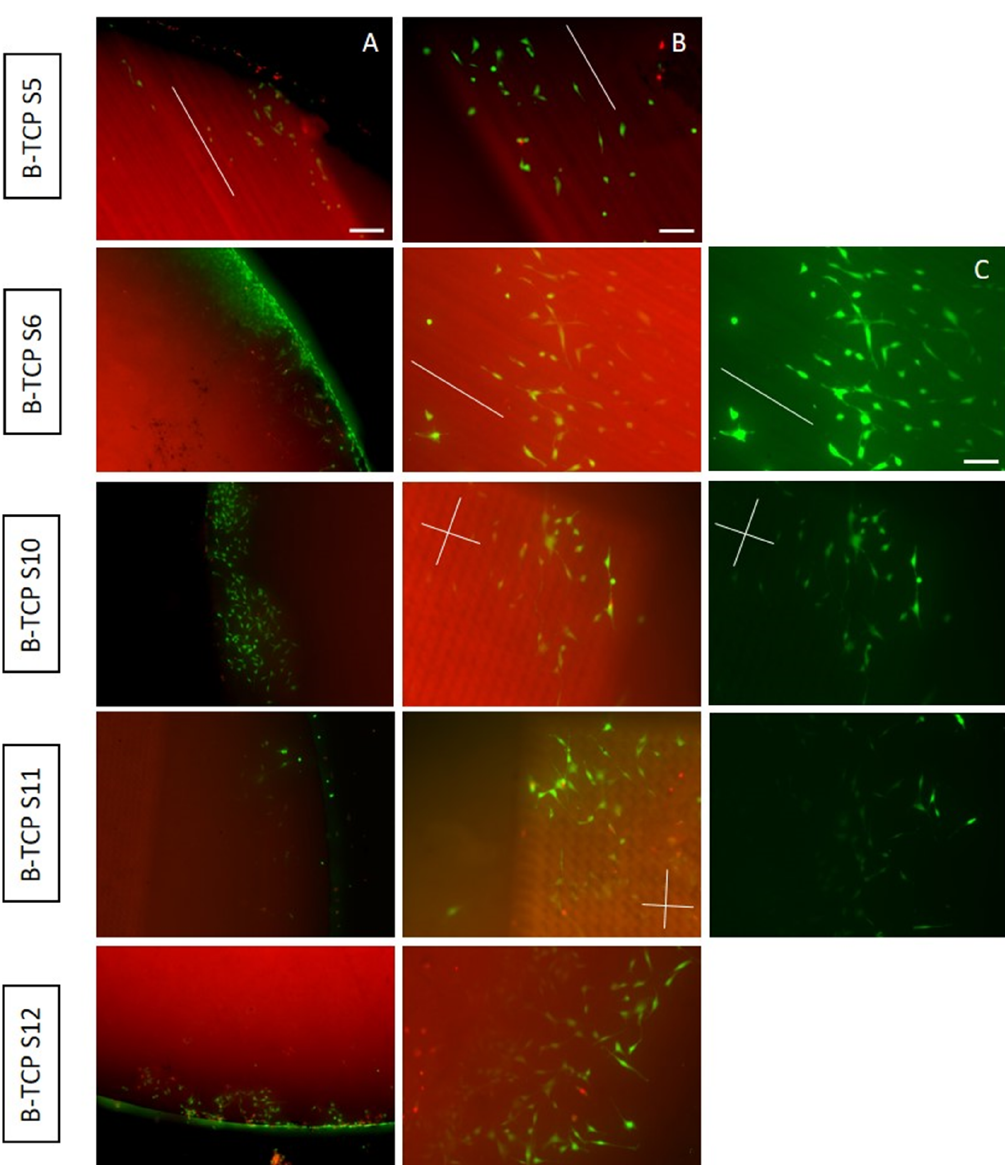
Figure 9. Fluorescence microscopy images of live/dead staining of MC3T3 mouse calvaria cells’ distribution 7 days in culture on different B-TCP ceramic laser-patterned surfaces. Living cells stain green, whereas dead cells stain red. The white lines show the lines of the pattern on the samples. ( A ) Overview images with scale bar of 200 µm. ( B ) Detailed images with scale bar of 100 µm. ( C ) Detailed images without a red filter clearly show that cells grow following the pattern of the surface (scale bar 100 µm).